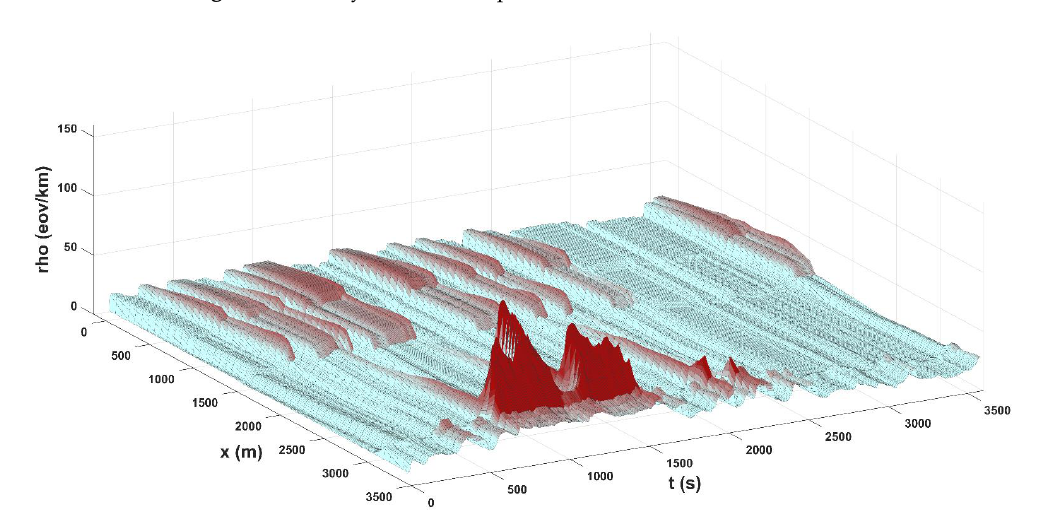
Figure 5. Density in time and space in scenario 3.